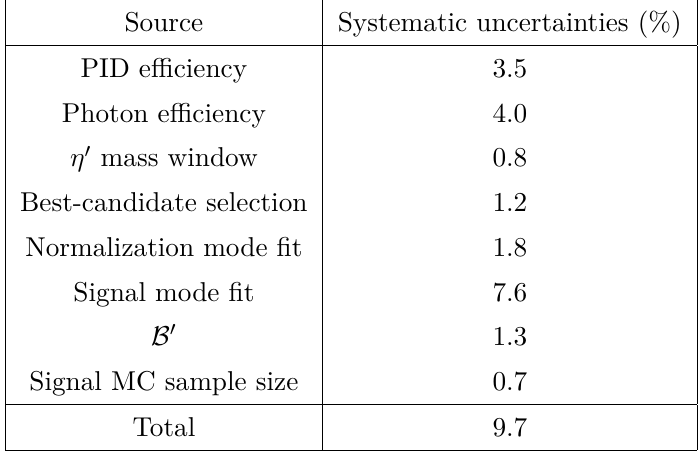
Table 2 . The sources of the relative systematic uncertainties (%) in the measurement of the ratio of branching